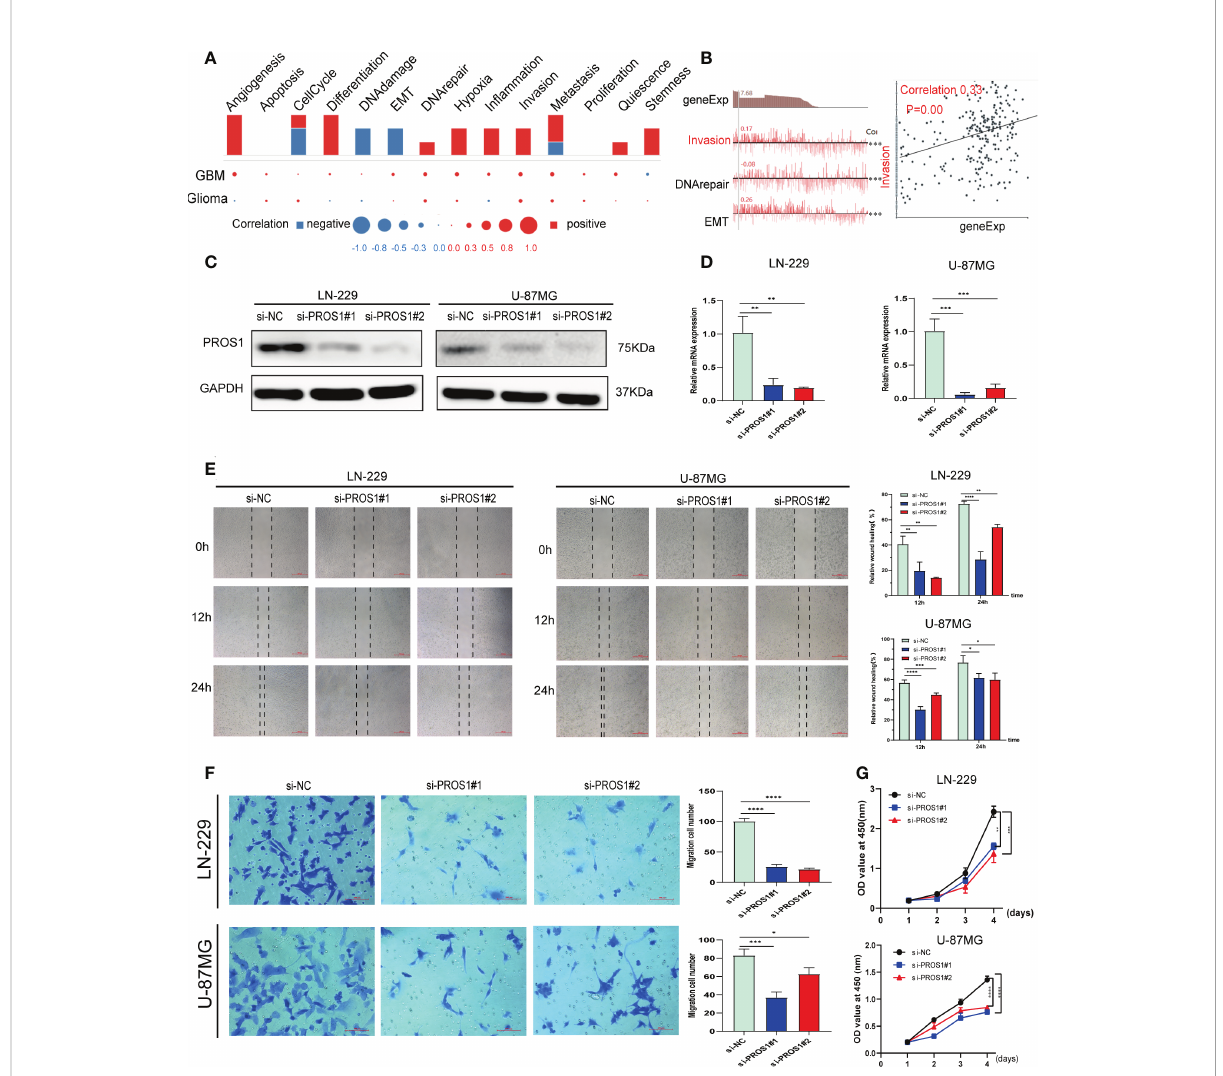
FIGURE 2 PROS1 increased proliferation, migration, and invasion of Glioma cells in vitro . (A) Single-cell analysis showed the functional state of PROS1 in Glioma. (B) CancerSEA analysis demonstrated that PROS1 positively correlated with invasion. (C, D) The western blotting and qRT-PCR were applied to analyze the protein and mRNA expression level of PROS1 after transfection by siPROS1 or PROS1 knockdown control for 24 h in LN- 229 or U-87MG cells. Wound healing assays (scale bar: 500 m m) (E) and Transwell assays (scale bar: 100 m m) (F) were performed in transfected LN-229 or U-87MG cells to evaluate cell migration ability. (G) Cell proliferation of LN-229 or U-87MG cells after knocking down was determined by CCK8 assays. (*, P < 0.05; **, P < 0.01; ***, P < 0.001; ****, P <